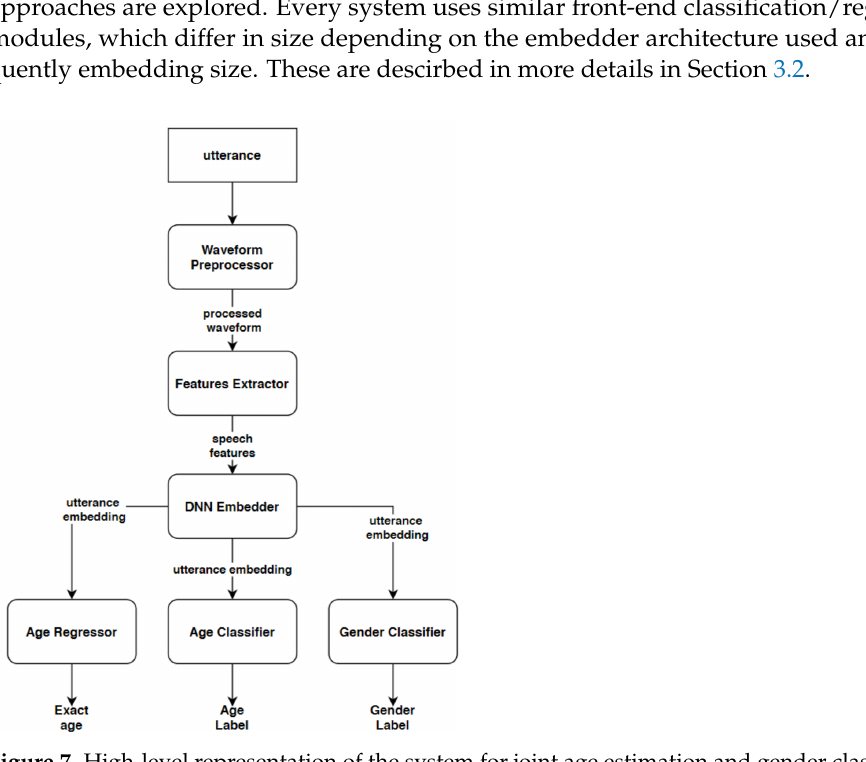
Figure 7. High-level representation of the system for joint age estimation and gender